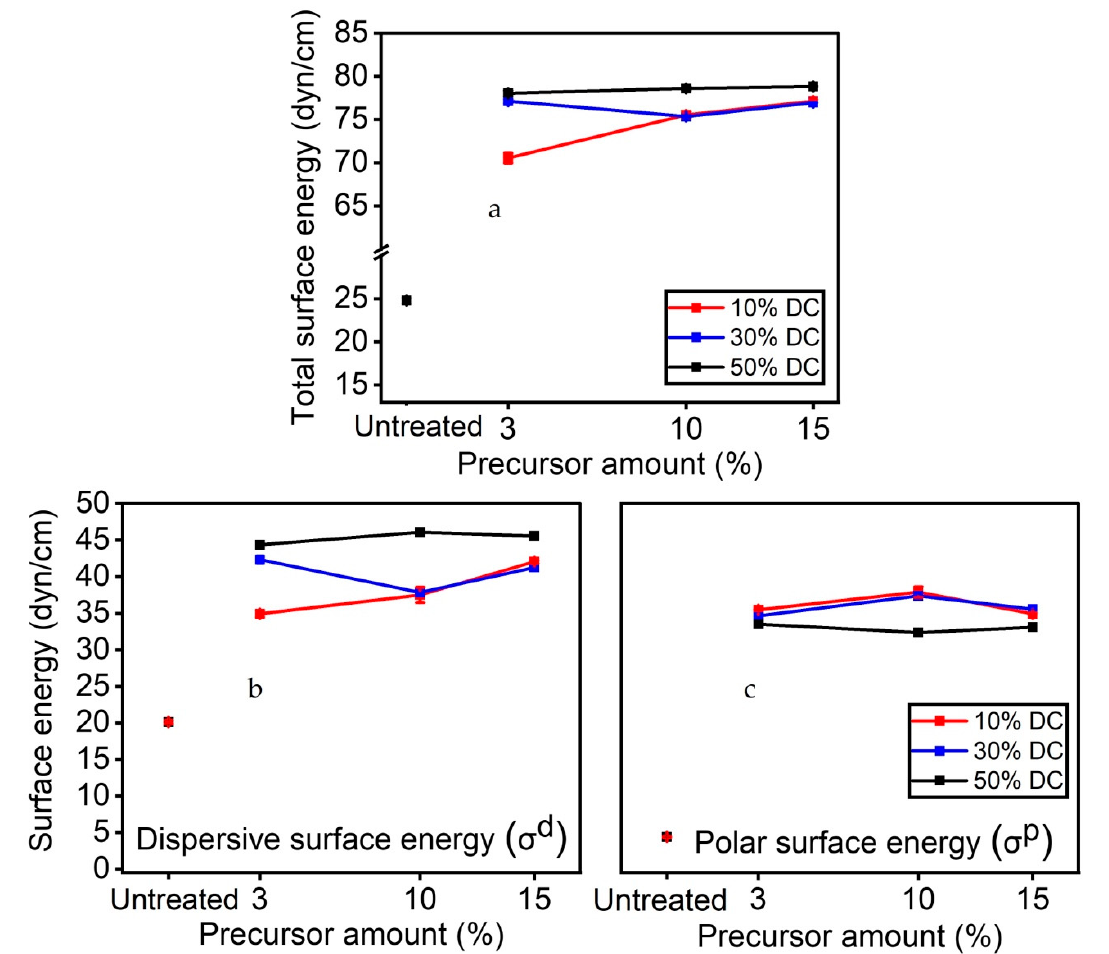
Figure 7. ( a ) Total surface energy; ( b ) dispersive component of surface energy; and ( c ) polar component of surface energy as a function of precursor for each duty cycles.